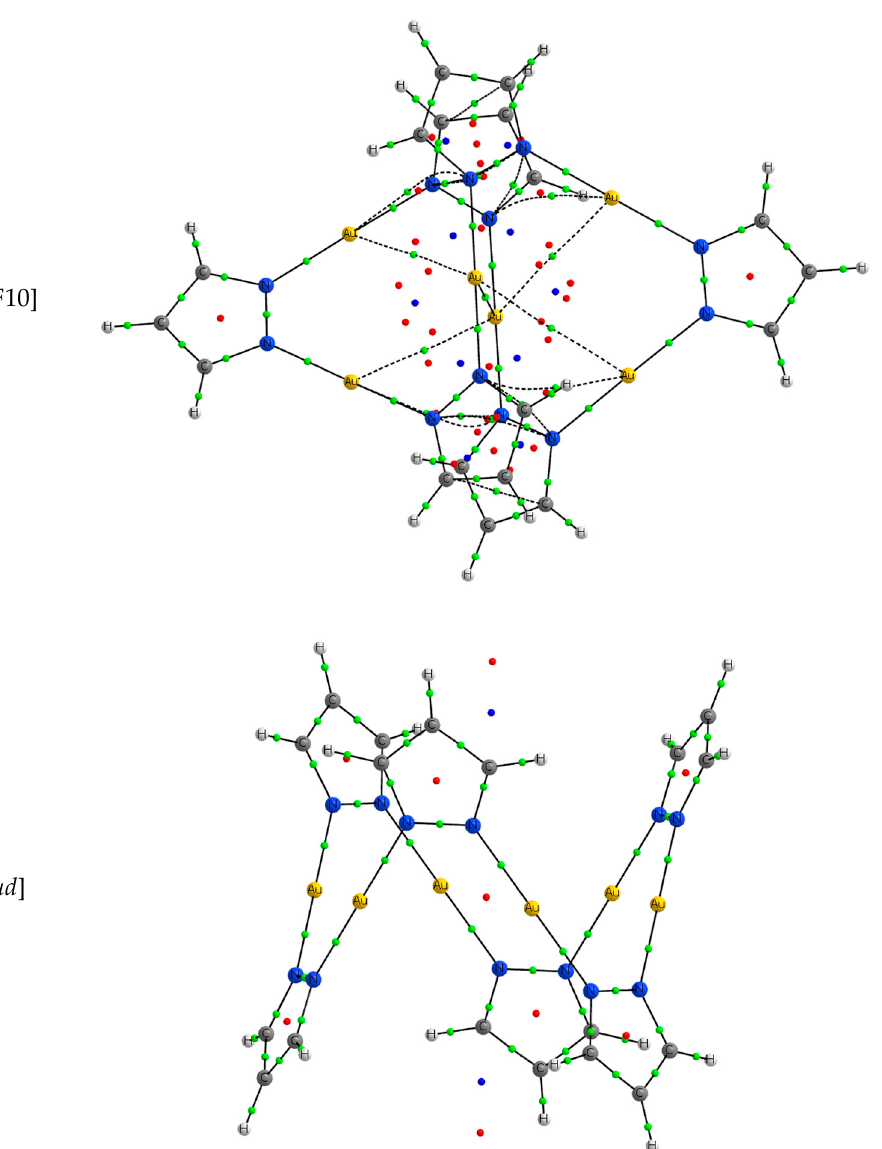
Figure 20. Molecular graph of the (pzAu) n complexes studied. The location of the bond, ring, and cage critical points are indicated with green red and blue dots.